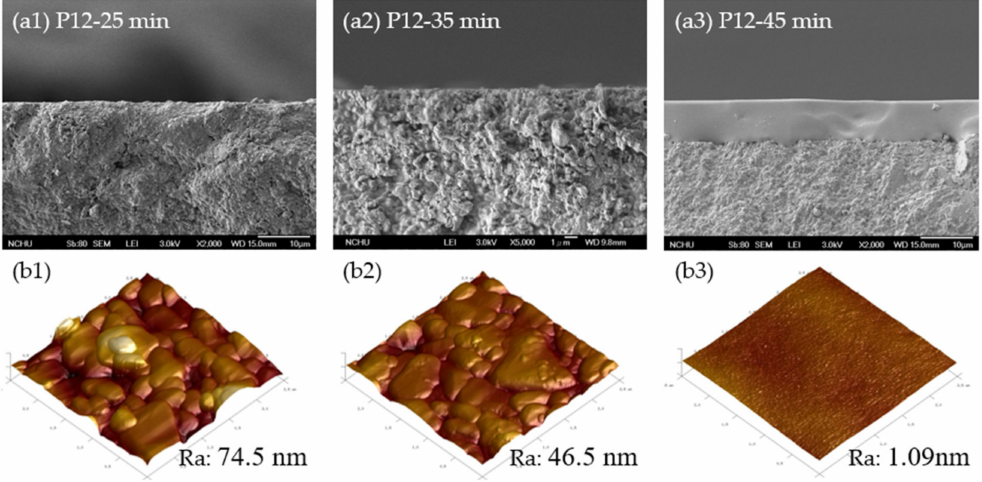
Figure 4. SEM ( a ) and AFM ( b ) images of the P12 membrane prepared at different reaction times: ( a1 , b1 ) 25 min, ( a2 , b2 ) 35 min and ( a3 , b3 ) 45